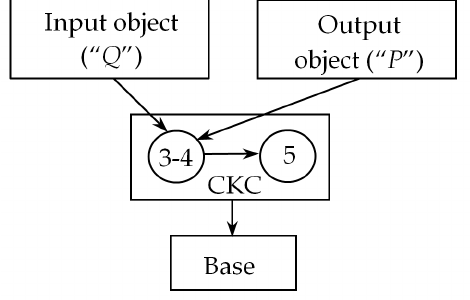
Figure 5. Block structure of the PM with two sliders.